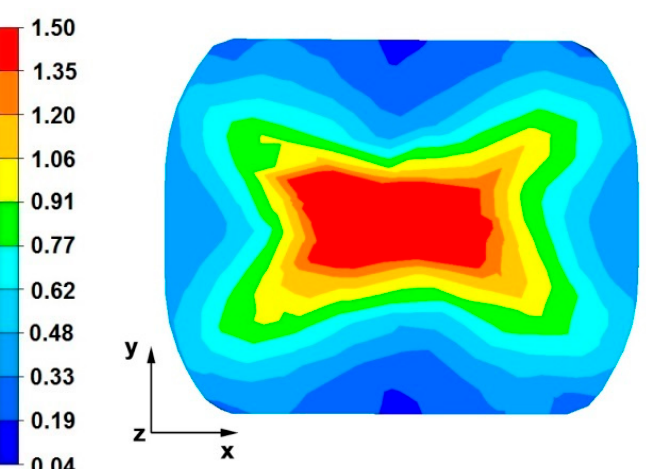
Figure 10. Distribution of the effective strain values on the surface of the cross-section of the sample with modeled discontinuity after rotation by 90° and re-deformation with 35% reduction.